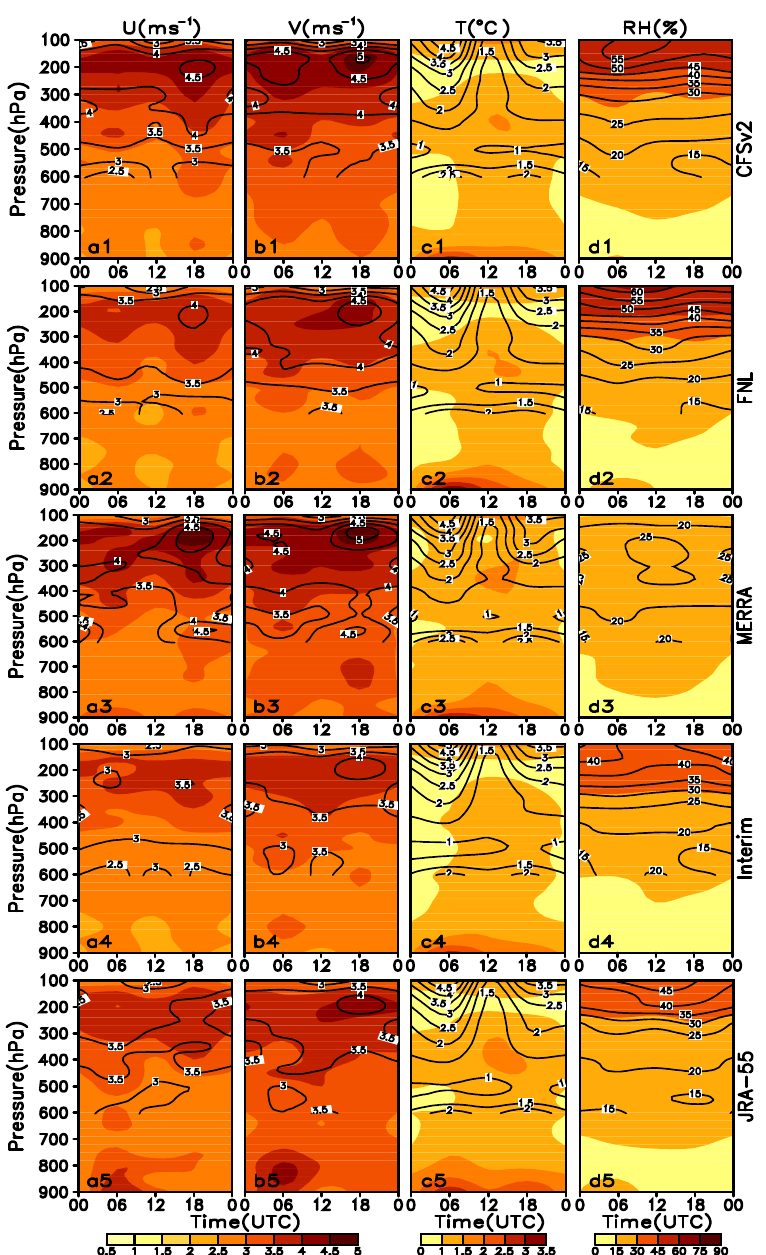
Figure 5. The diurnal variations of the RMS error of U ( a1 – a5 ), V ( b1 – b5 ), T ( c1 – c5 ), and RH ( d1 – d5 ) in the five GDs against the radiosonde data, averaged over sounding five sites in the basin (shaded) and six sites in the TP (contour) during late June–early August (2011–2015).